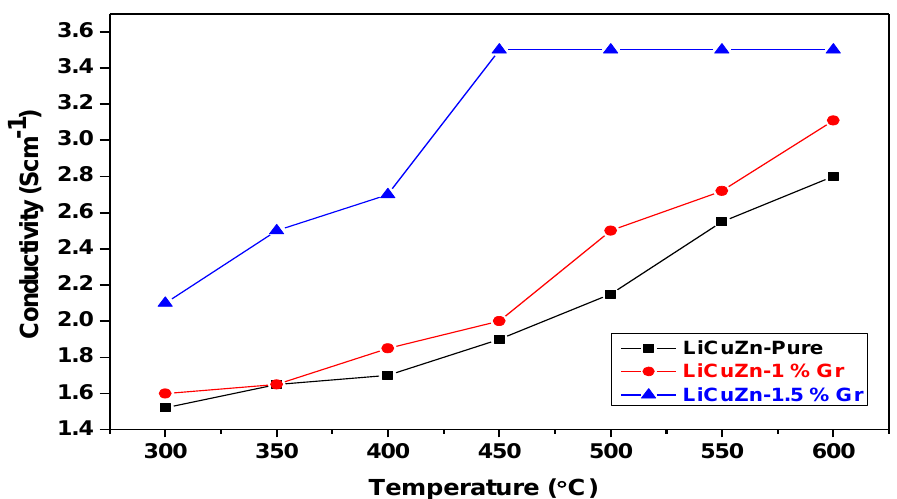
Figure 4. FTIR spectrum of prepared materials.